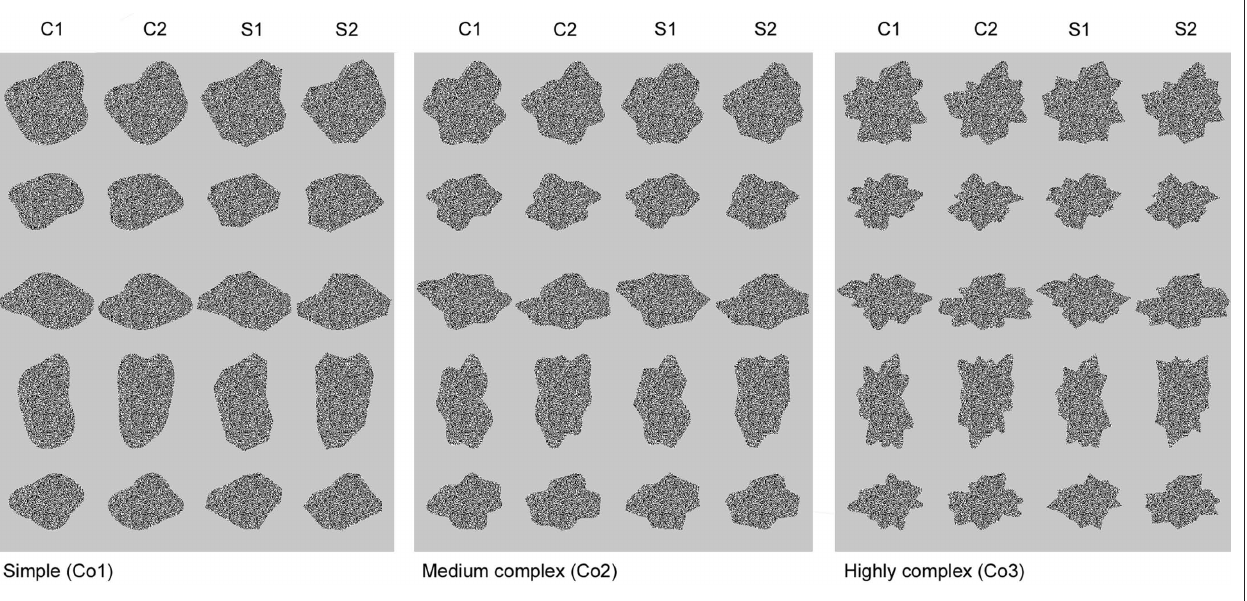
Figure 1 | Stimulus set used in experiment 1. The set is subdivided in three groups of 20 shapes that are approximately equal in complexity; Co1, Co2 and Co3, with increasing numbers denoting increasing complexity. The rows contain five calibrated sets of shapes that can be used to compare neural sensitivity to either changes in the phase of the FBDs or the presence of curved versus straight contours, as a function of complexity. The shapes in columns C1 and C2 are curved and differ in the phase of their FBDs. The shapes in columns S1 and S2 are created